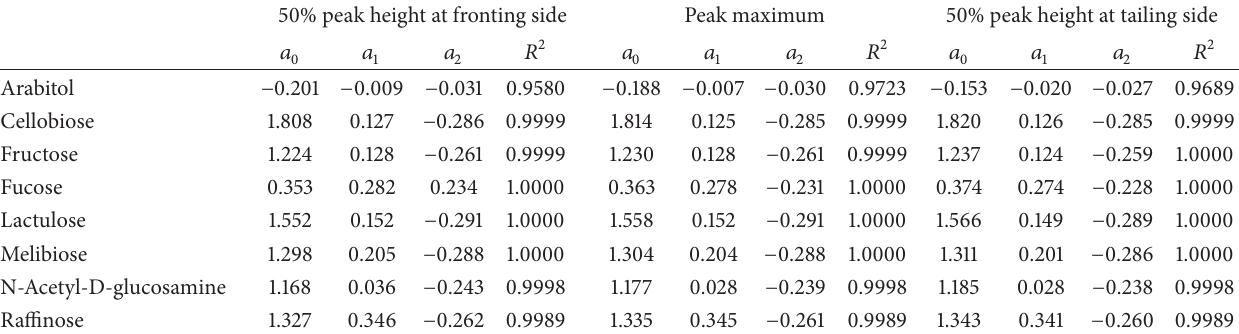
Table 1: Parameters of isocratic retention models described by (1). The eluent concentration is expressed as mM. 50% peak height at fronting